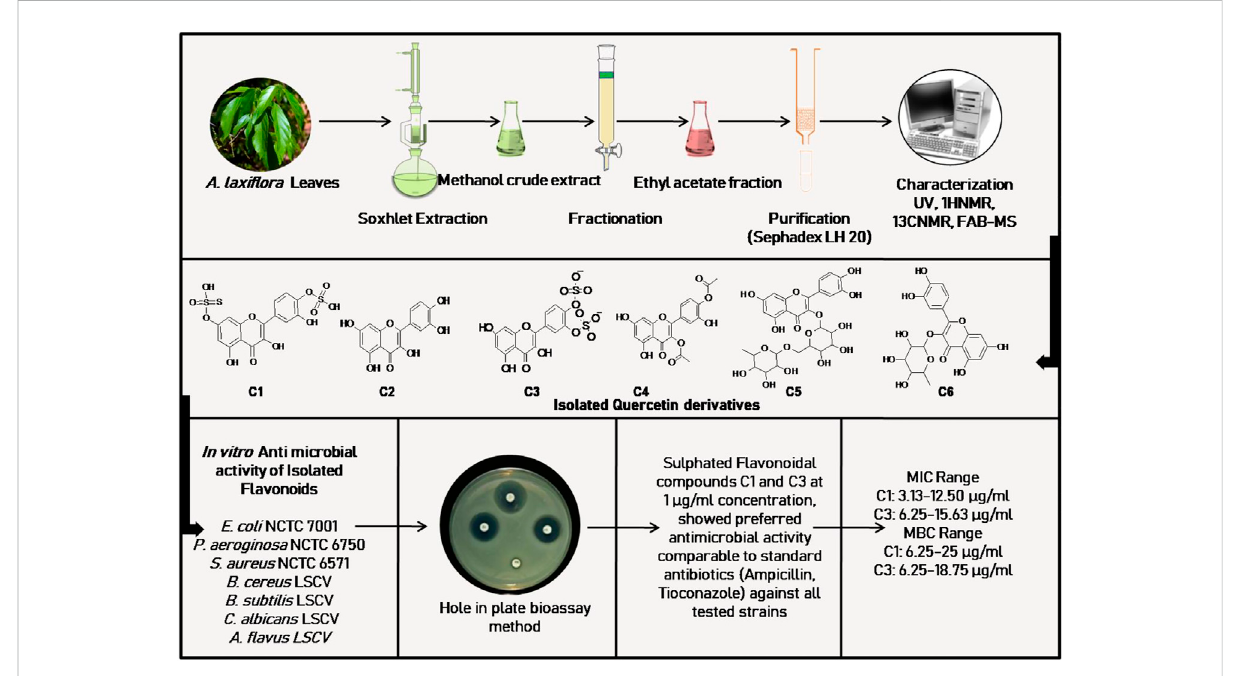
FIGURE 4 Anti-microbial activity of isolated fl avonoids from A. laxi fl ora , derived from Ogundipe et al. (2001b).